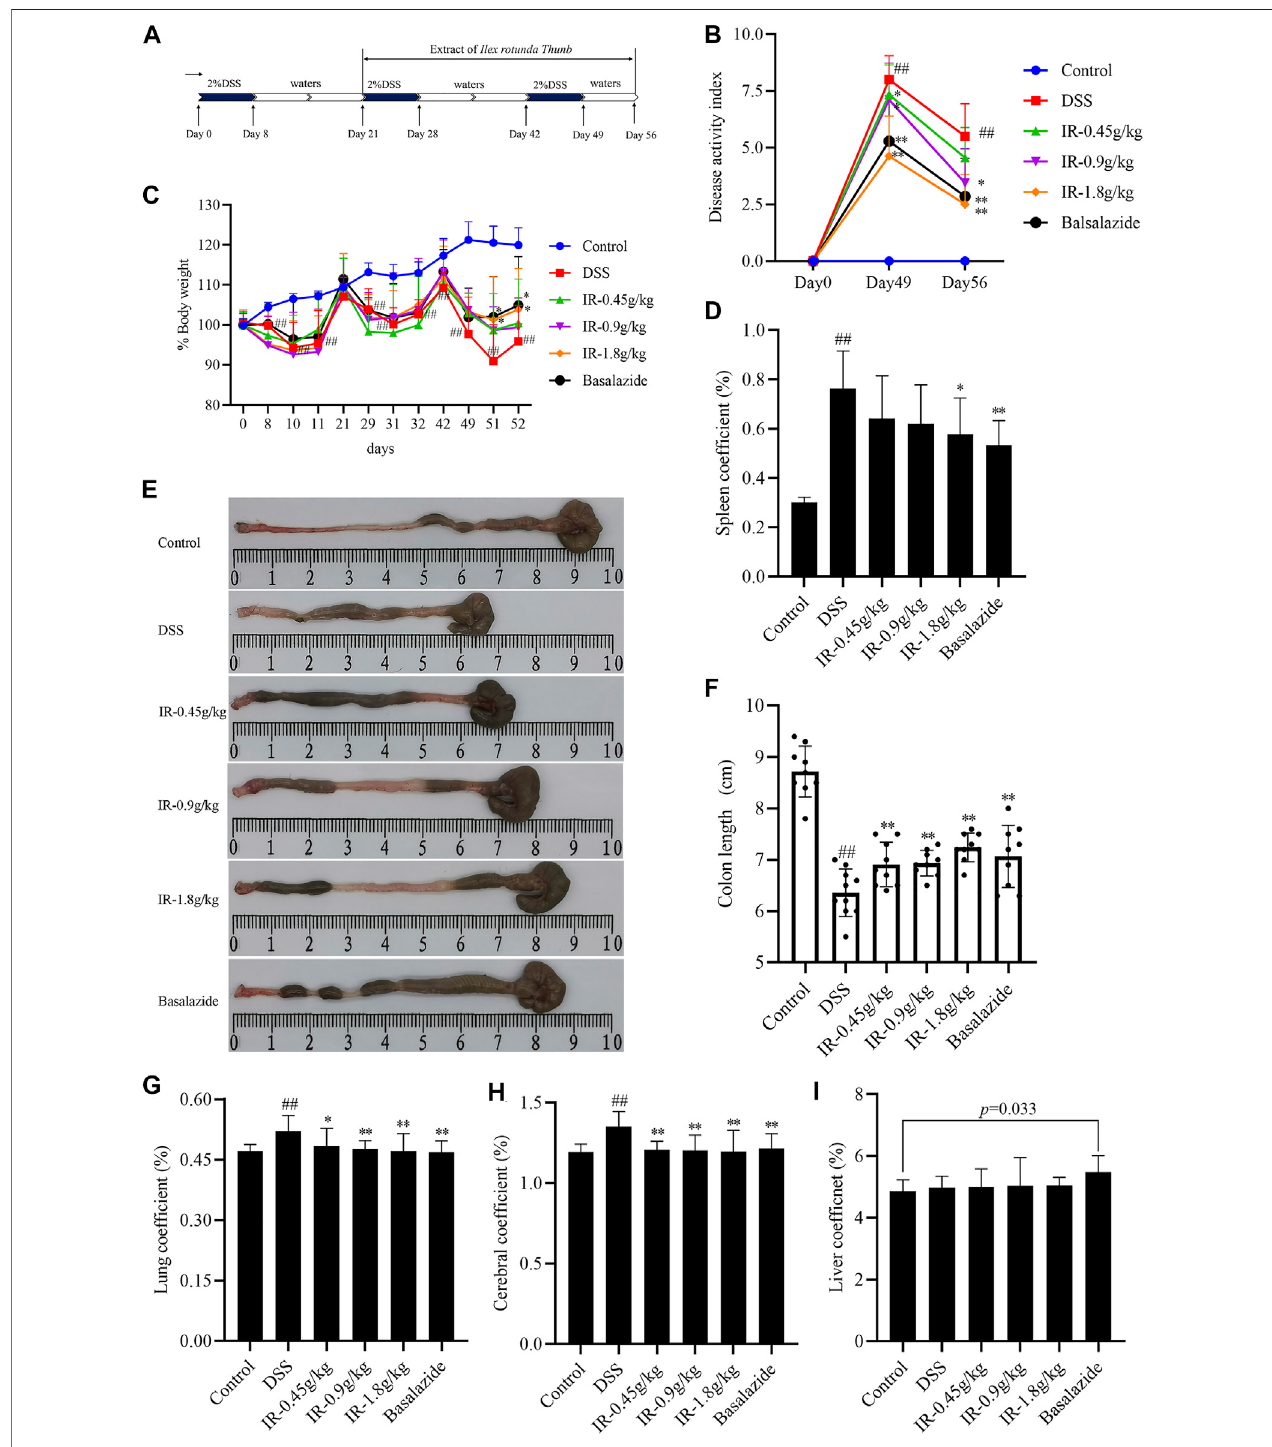
FIGURE 2 | IR alleviates the pathological symptoms of DSS-induced chronic UC mice. (A) Experimental design. (B) Disease activity index of each group. (C) The bodyweight change ofmice ineach group duringthe experiment. (D) Spleen coef fi cient ofmicein each group. (E) Representativecolonimages at day56. (F) Statistical graph of colon length. (G) Lung coef fi cient. (H) Cerebral coef fi cient. (I) Liver coef fi cient. All data were compared using one-way ANOVA, and p -values re fl ected differences between experimental groups ( n = 9).